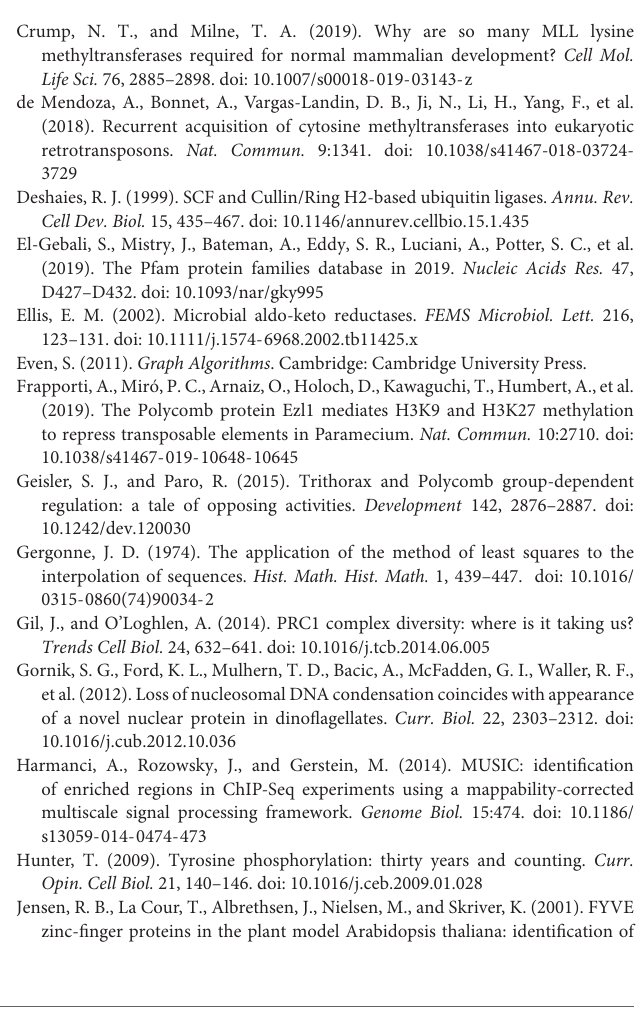
FIGURE S2 | Profile plot of histone marks including H3K4me3 and gene expression levels of H3K4me3 marked versus unmarked genes. (A) Averaged tag-density profile for 6 histone modifications are plotted for TSS of 12k genes with 3 kb upstream and 10 kb downstream regions. Regions are ordered and scaled to TSS as reference point. (B) Boxplot showing the differences in expression levels of genes with and without histone modifications. Box represents